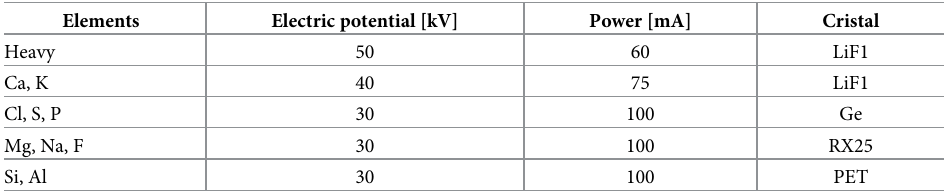
Table 2. Analytical conditions used for XRF